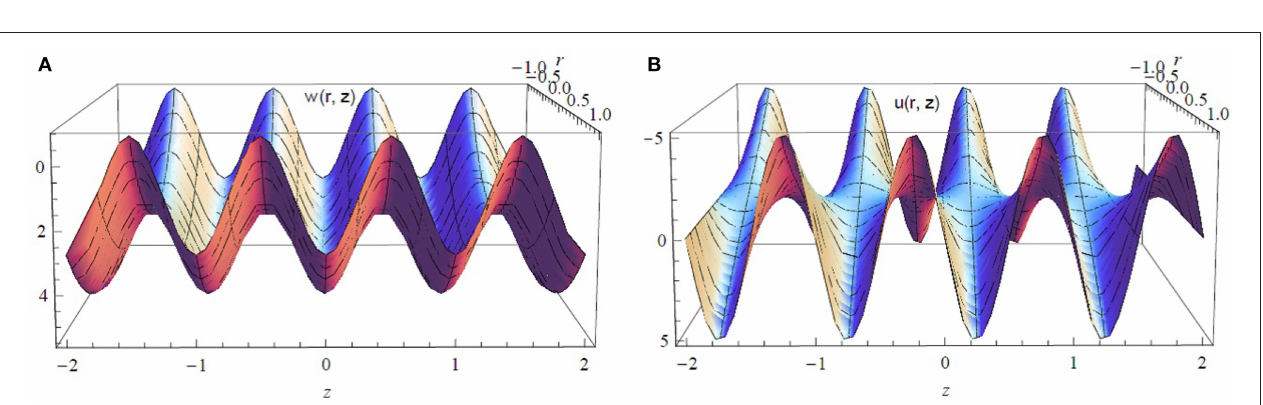
FIGURE 5 | Streamline patterns for (A) ǫ = 0.2, (B) ǫ = 0.3, and (C) ǫ = 0.4. Results obtained for α * = β * = 0.7 and ¯ Q = 1.5.